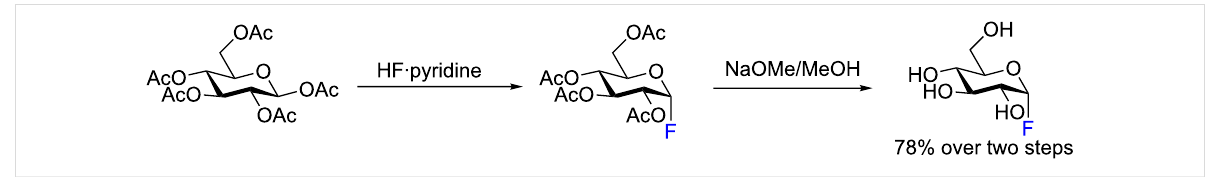
Scheme 17: Synthesis of the α -fluoroglucosyl